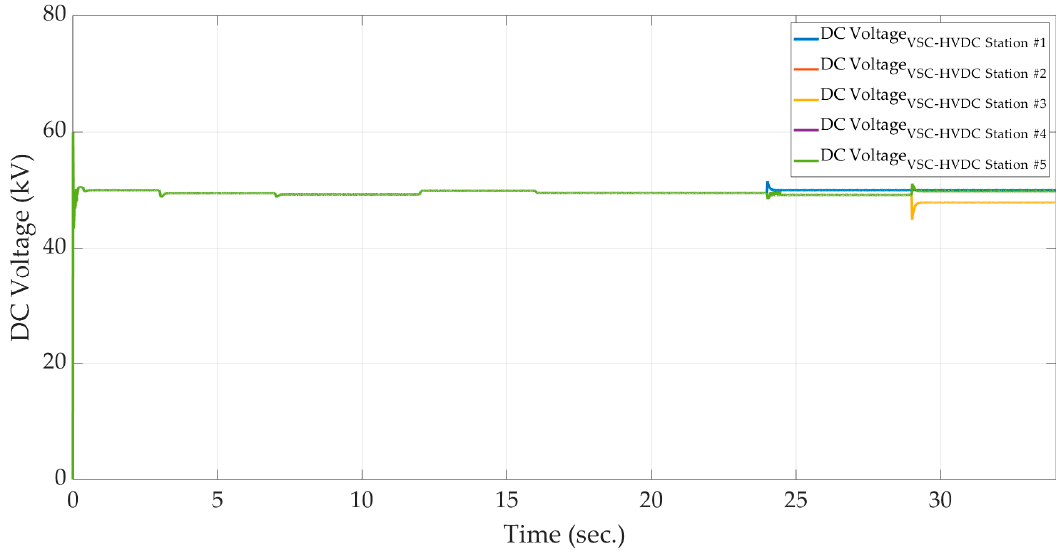
Figure 13. The DC voltage profile of different VSC-HVDC stations in the second scenario.